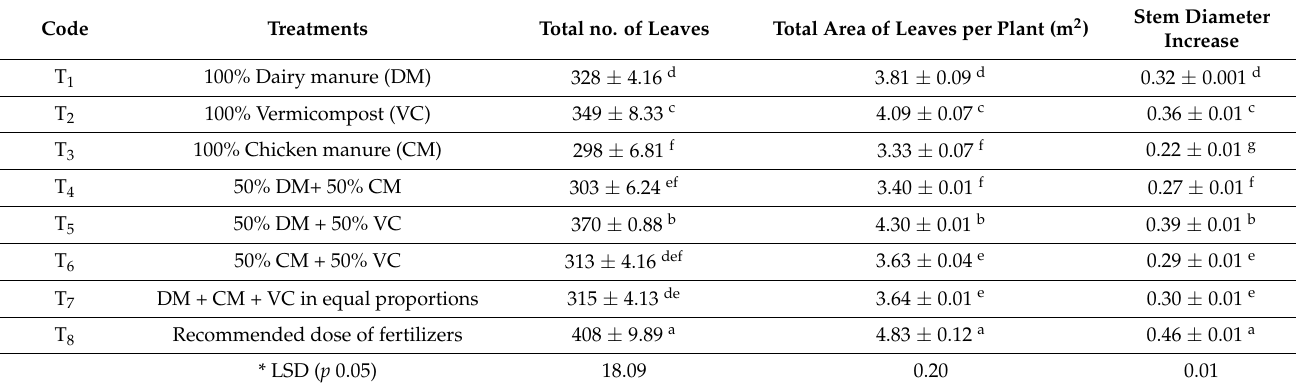
Table 1. Impact of organic manures on the plant growth characteristics of Actinidia deliciosa cv ‘Allison’.